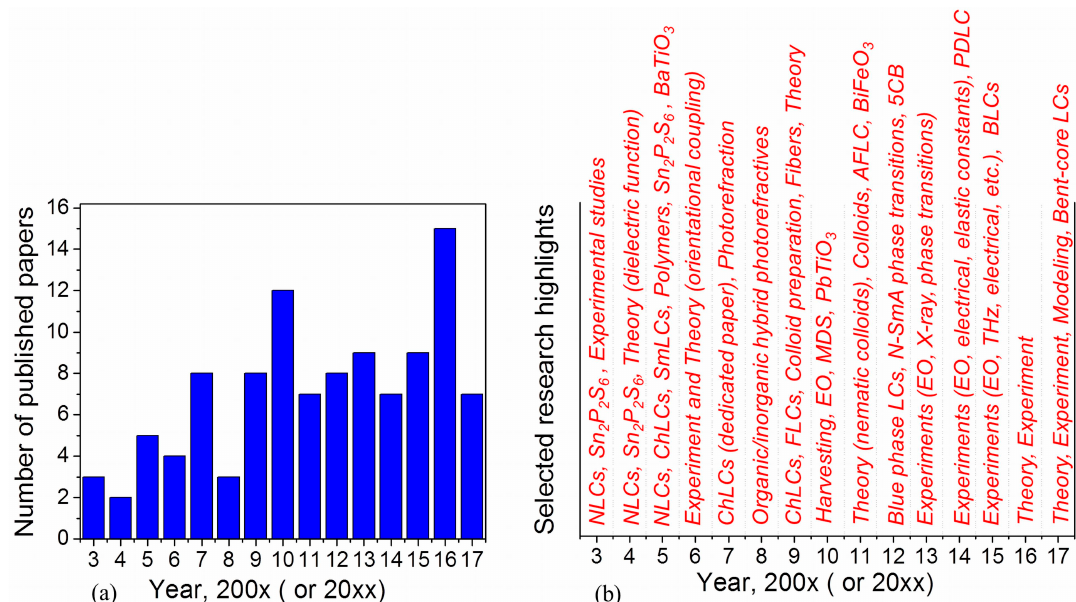
Figure 2. ( a ) Number of papers published during the 2003–2017 period; and ( b ) major research highlights. Nematic liquid crystals (NLCs), cholesteric liquid crystals (ChLCs), smectic liquid crystals (SmLCs), ferroelectric liquid crystals (FLCs), antiferroelectric liquid crystals (AFLC), polymer dispersed liquid crystals (PDLC), blue phase liquid crystals (BLCs), liquid crystals (LC), electro-optics (EO), molecular dynamics simulation (MDS).